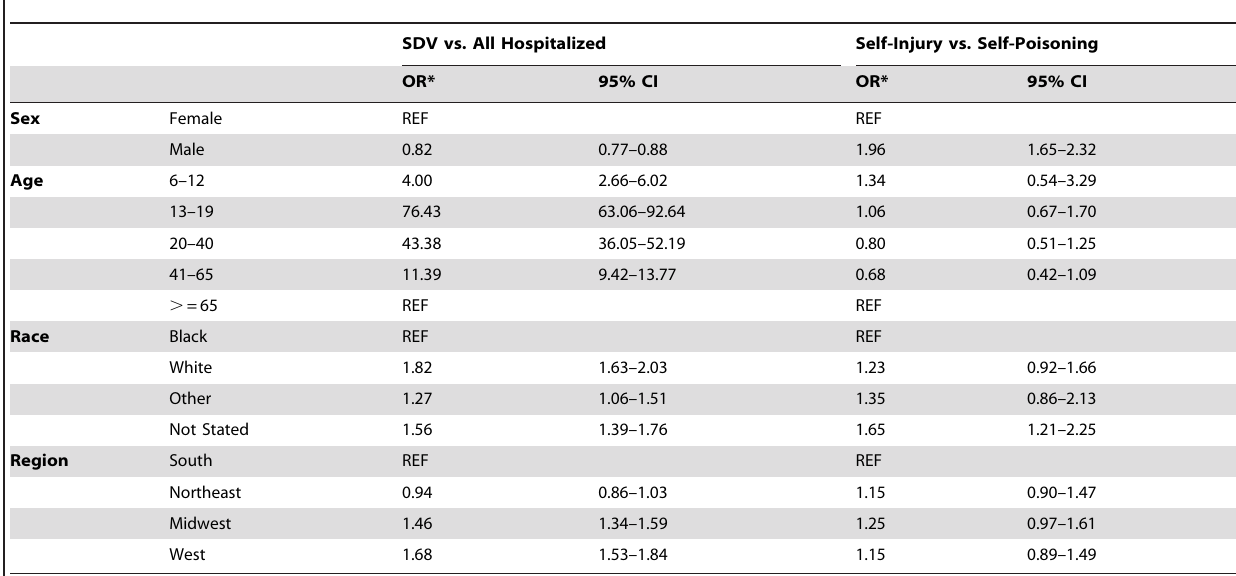
Table 2. Associations of demographic characteristics in hospital discharges with non-fatal self-directed violence